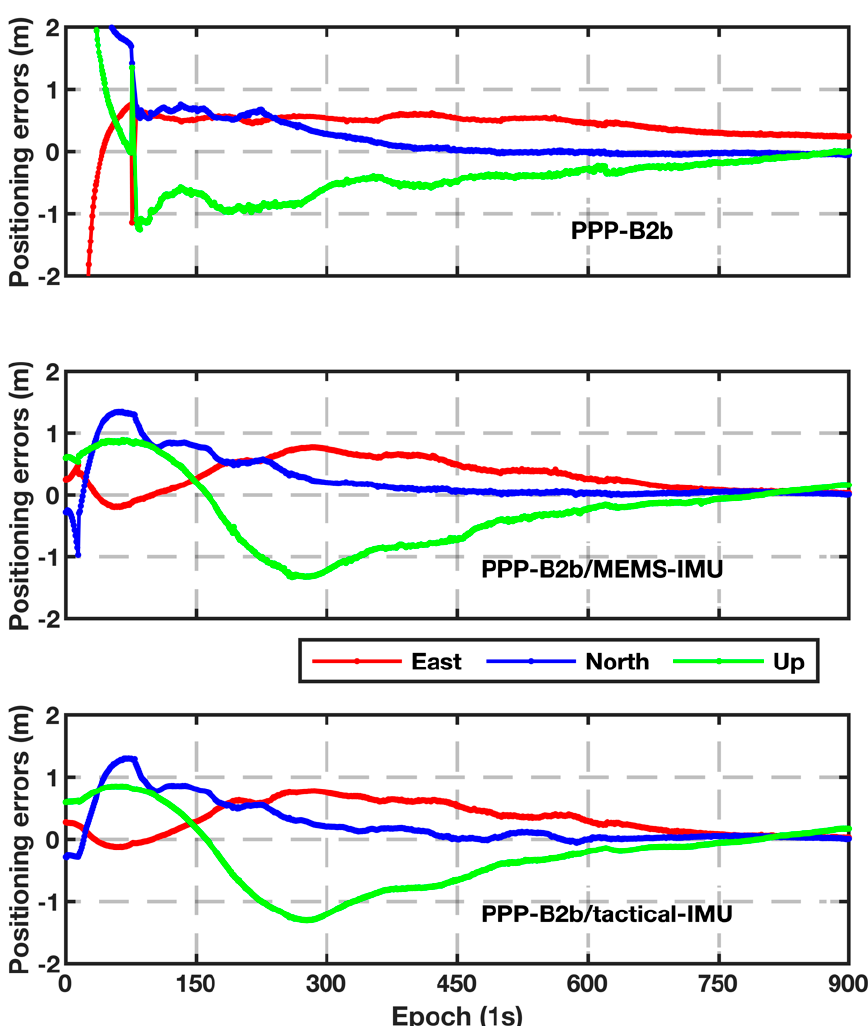
Figure 11. Positioning errors of PPP-B2b only ( top panel), PPP-B2b/MEMS-IMU loosely coupled integration ( middle panel), and PPP-B2b/tactical − IMU loosely coupled integration ( bottom panel) during the period from 09:35:00 to